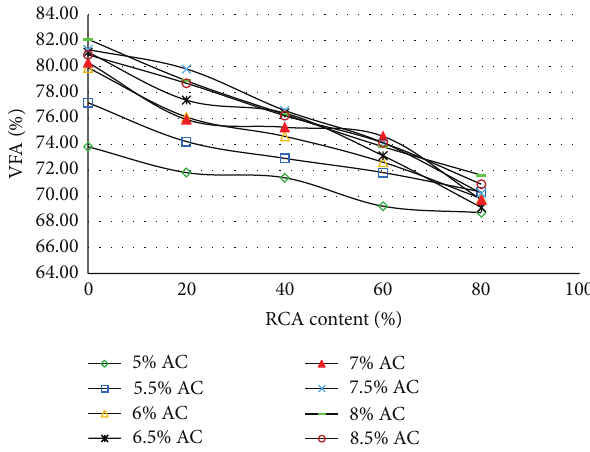
Figure 6: VFA values versus RCA content for each percentage of asphalt